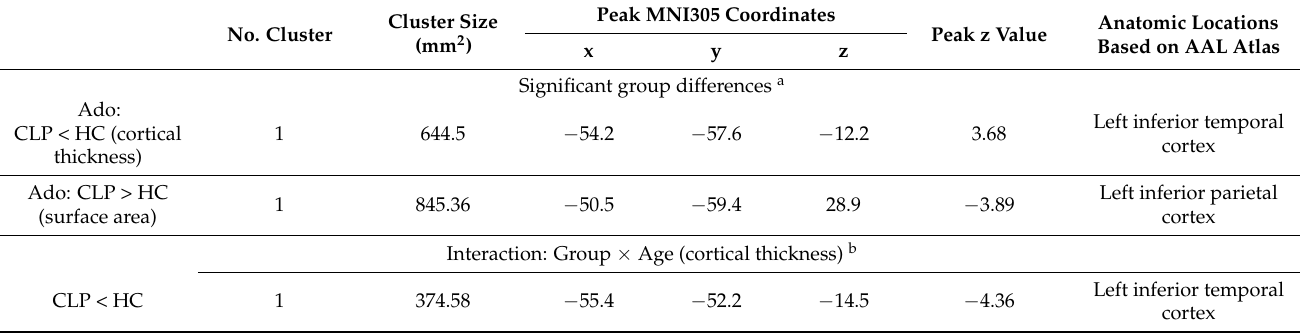
Figure 5. Decreased seed-based functional connectivity in CLP participants compared with HC. ( A ) The left inferior temporal cortex (ITG.L) was set as the seed, and the cortical thickness exhibited a significant “group × age” interaction effect.( B ) Significantly decreased connectivity of CLP partici- pants compared to HC in the functional connectivity analysis with ITG.L as the seed. Gender and age were regressed out as covariates, and significance was set at cluster-wise p < 0.05 with family-wise error (FWE) correction for multiple comparisons. Table 3. Statistical results using surface-based morphometry analyses.